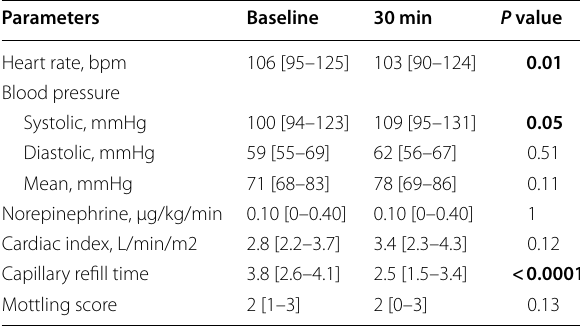
Table 2 Global hemodynamic and tissue parameters at baseline and 30 min after fluid infusion parameters